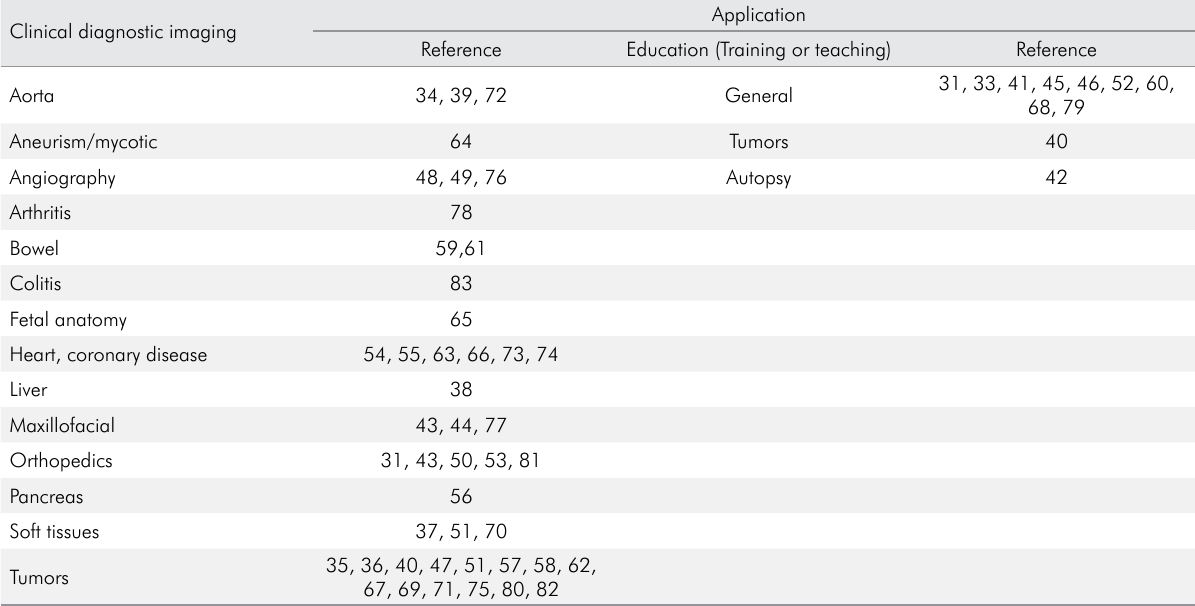
Table. Summary of the selected references regarding the application reported. Clinical diagnostic